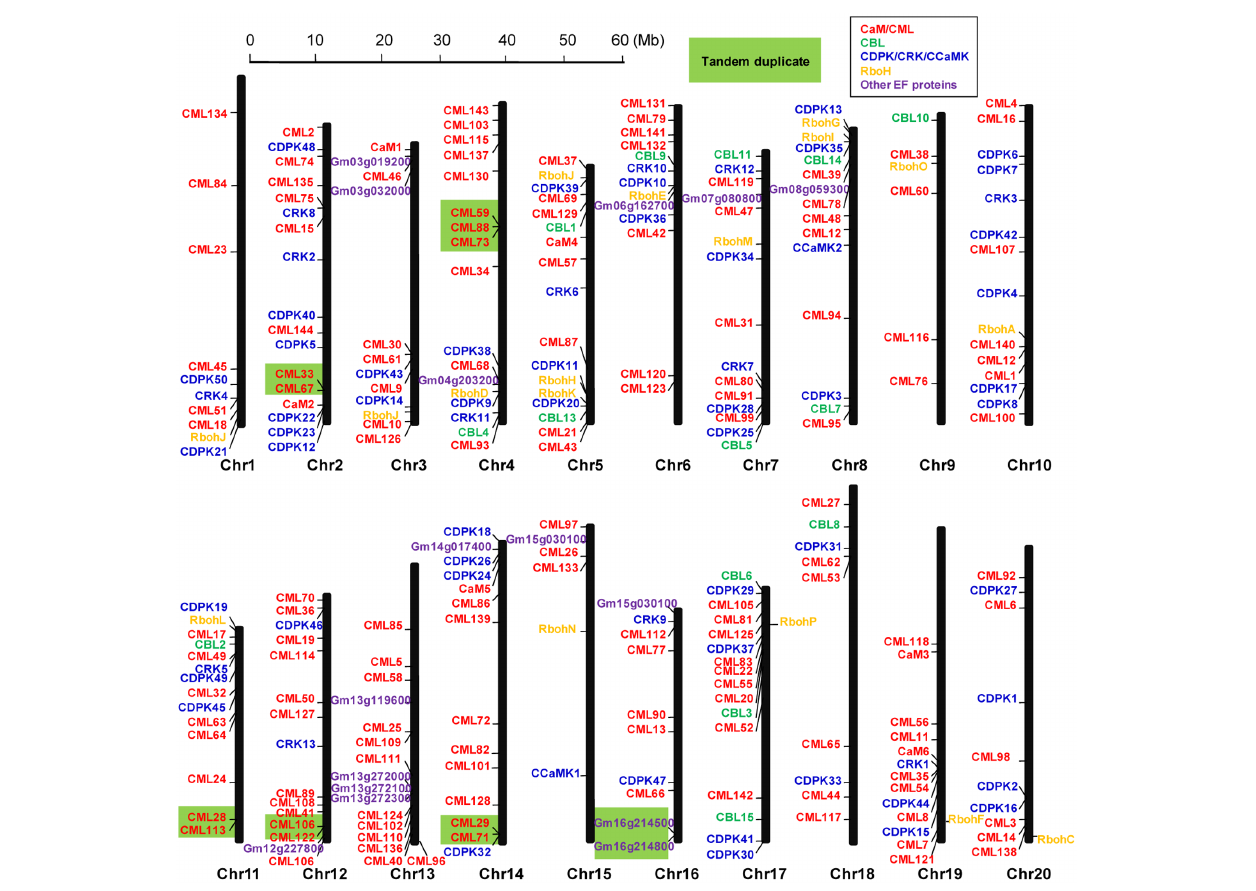
FIGURE 2 | Graphical representation of locations for putative EF-hand protein-encoding genes on each soybean chromosome. CaM/CMLs are marked in red, CBLs are marked in green, CDPK/CRK/CCaMKs are marked in blue, respiratory burst oxidase homologs (Rbohs) are marked in orange, and the other unclassified EF-hand proteins (UEPs) are marked in purple. Genes within a light green box are putatively tandemly